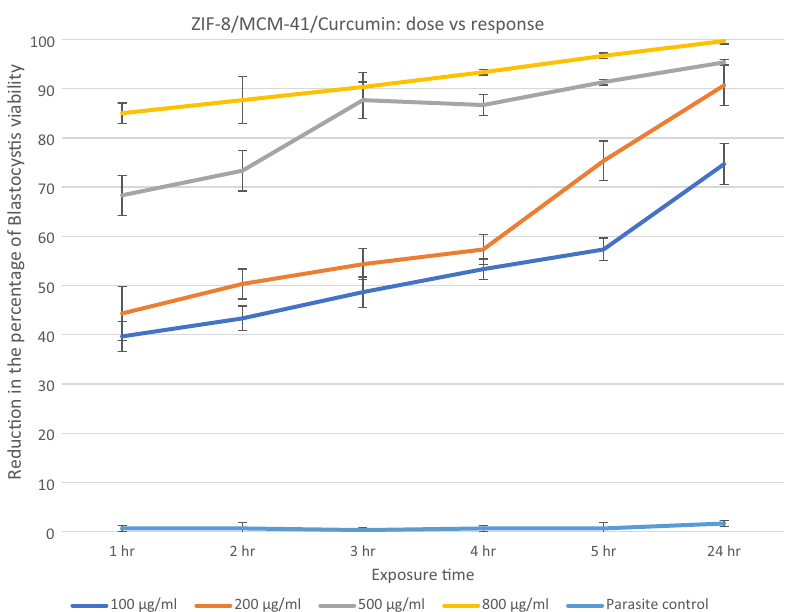
ZIF-8/MCM-41/Curcumin: dose vs response